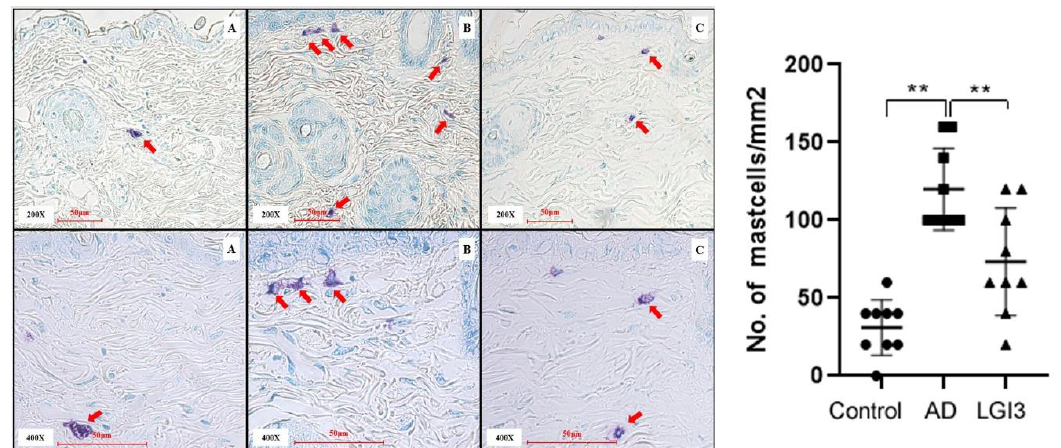
Figure 7. Leucine-rich glioma inactivated 3 (LGI3) treatment ameliorates granulated mast cells in atopic dermatitis (AD) models. Representative photomicrographs of dorsal skin from each group of mice on day 15 (Toluidine blue staining 200×, 400×). ( A ) Dorsal skin of control group; ( B ) dorsal skin of AD group; ( C ) dorsal skin of LGI3 group. Thick arrows indicate granulated mast cells infiltrated into the skin tissue. The number of granulated mast cells was within 1 mm 2 . Infiltration of granulated mast cells in the AD model (11.00 ± 3.46, P < 0.01) was conspicuously much more than the control group (2.29 ± 0.95) and the LGI3 group (4.57 ± 2.15) (N = 7). Data are expressed as mean ± S.D. (** P < 0.01 vs. AD group). Differences between the control and AD model, LGI3 and AD model group were estimated by ANOVA.